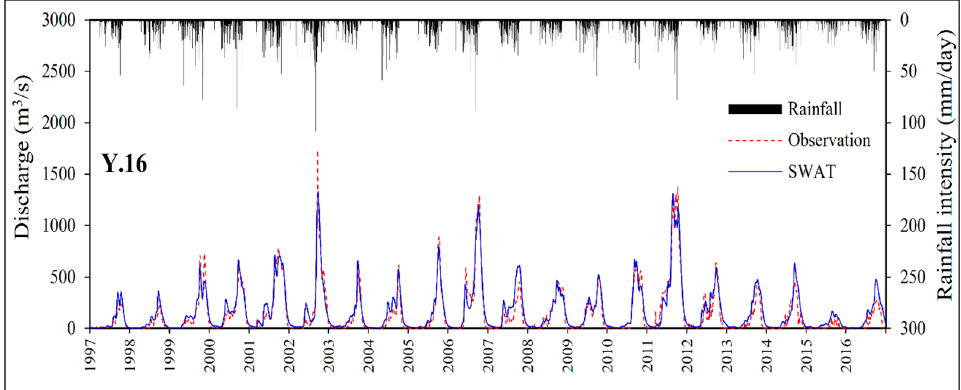
Figure 2. Comparison of daily river discharge from simulation and observation at station Y.16.